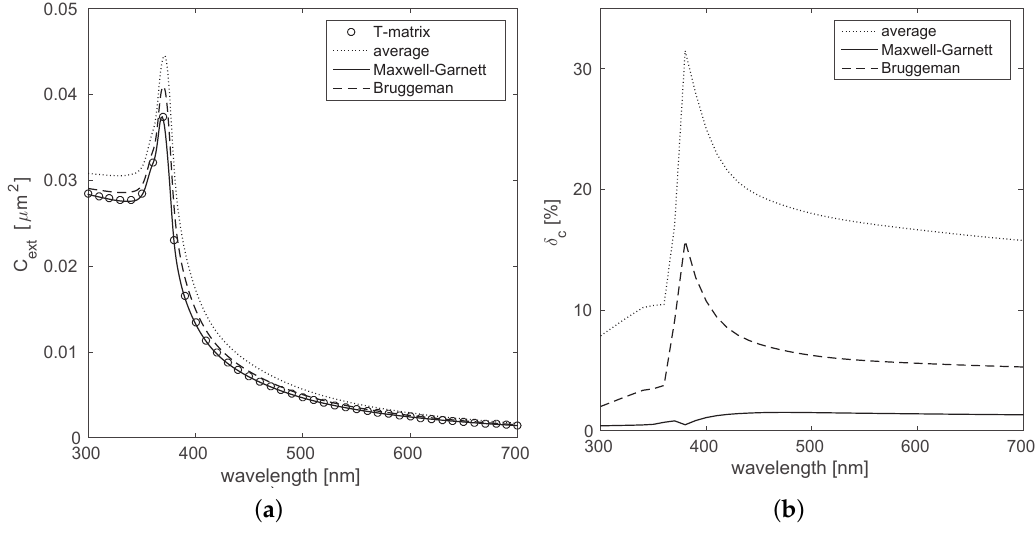
Figure 2. Extinction cross sections of mesocrystalline particle computed using the superposition T-matrix method and the Lorenz-Mie theory ( a ); Deviation of the Lorenz-Mie results from the exact superposition T-matrix extinction cross section ( b ).